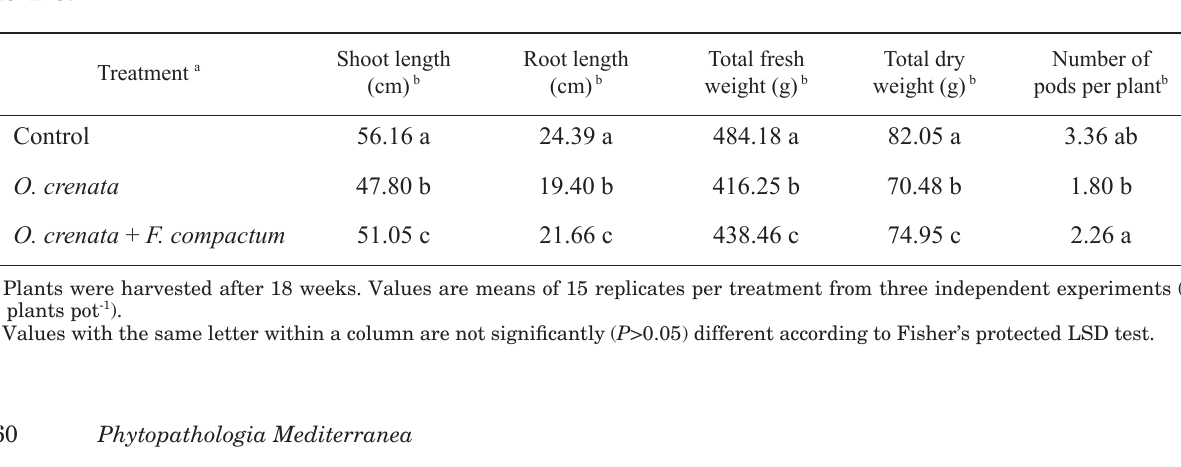
Table 4. Effect of the application of Fusarium compactum ( Fusarium isolate 22) and/or Orobanche crenata on the growth characteristics of faba bean ( Vicia faba ) plants grown in an evaporative-cooled greenhouse maintained at 25±2°C.